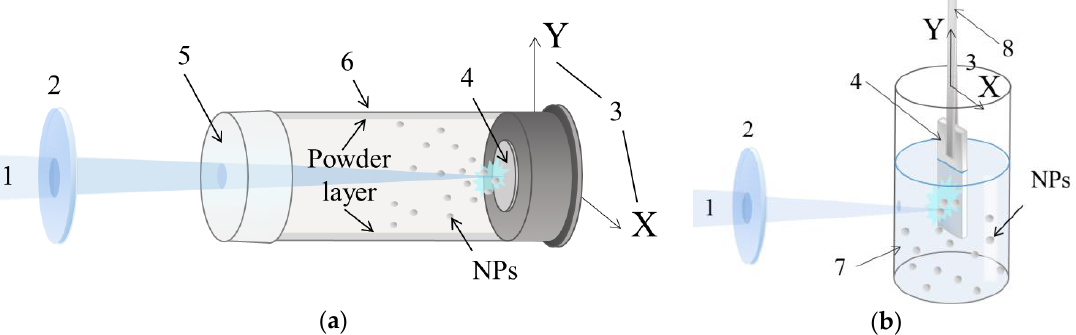
Figure 1. Setups used in the present study for PLA in air ( a ) and water ( b ). 1: laser beam; 2: focusing lens; 3: movement direction for target; 4: Zn target; 5: polyethylene membrane; 6: cylindric reactor: 7: distilled water; 8: target holder.